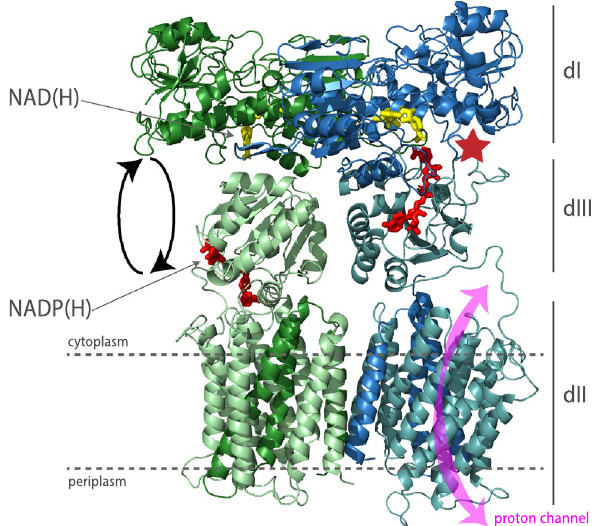
Figure 1. Homology model of E. coli transhydrogenase. Representation of the homology model of E. coli transhydrogenase based on the crystal structure of Thermus thermophilus transhydrogenase. The protein is shown as the homodimer as which it is present in the membrane. The two monomers are coloured blue and green respectively. Each monomer is composed of two subunits (lighter and darker shade of green and blue, respectively) which form three domains. For instance in the green monomer, domain I (dI) and part of domain II (dII) are formed by subunit α(dark green), whereas the remaining of dII and domain III (dIII) are formed by subunit β (light green). Shown in red and yellow are NADP(H) and NAD(H) respectively at their respective binding sites. dIII is in an asymmetric orientation in the two monomers with one dIII facing upwards and one dIII facing downwards. The NADP(H) binding domain dIII is believed to flip up and down by about 180° in order to bring the NADP(H) binding site close to the NAD(H) binding site or the proton channel. Hydride transfer (indicated by red star) happens when dIII is facing upwards. The proton channel is located in dII (indicated by pink double headed arrow). Structure rendered in Pymol (Schrödinger, v2.4.0, open- source version) and labelled in Adobe Illustrator